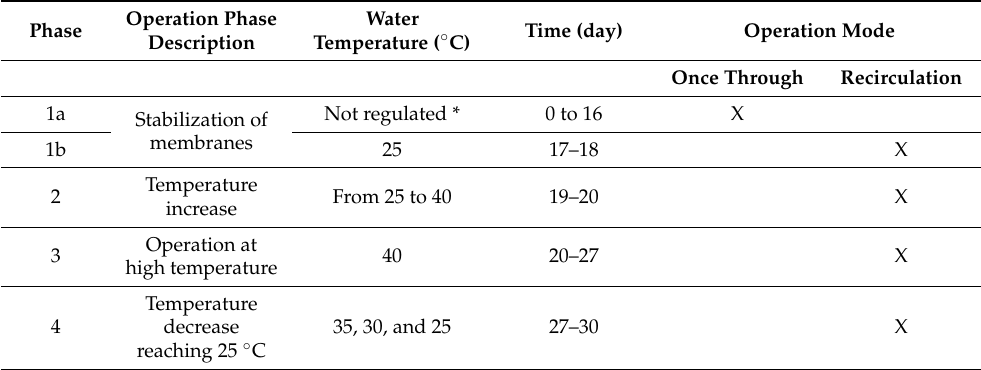
Table 2. Pilot operating conditions during the different phases.